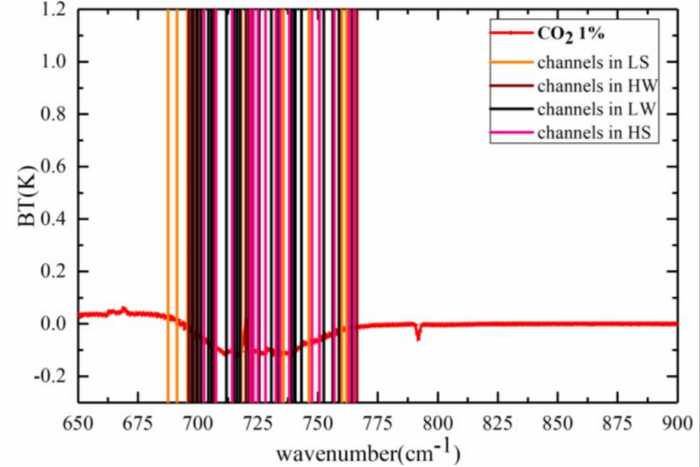
Figure 4. Selected channels used to retrieve CO 2